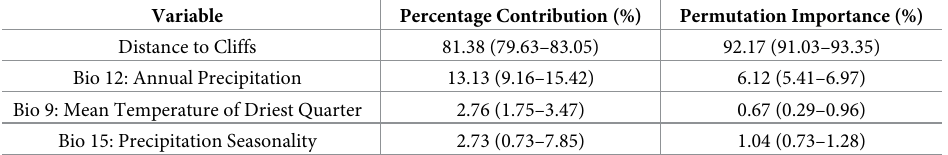
Table 2. Average (minimum—maximum) percentage contribution and permutation importance of each environ- mental variable to the ecological niche model.